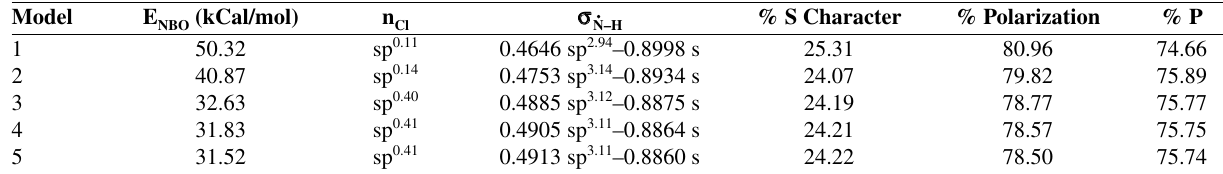
Table 6. NBO analysis of NH–Cl interaction for threonine hydrochloride clusters calculated with M06-2X/6-311++G(d,p) method. Model